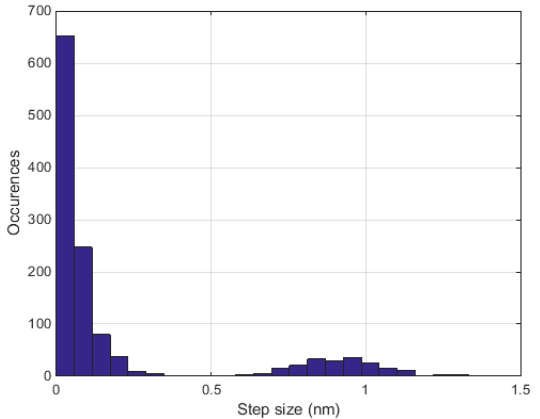
Figure 2. Number of occurrences of optical–parametric oscillator wavelength step sizes between 3.2 µm and 3.5 µm.